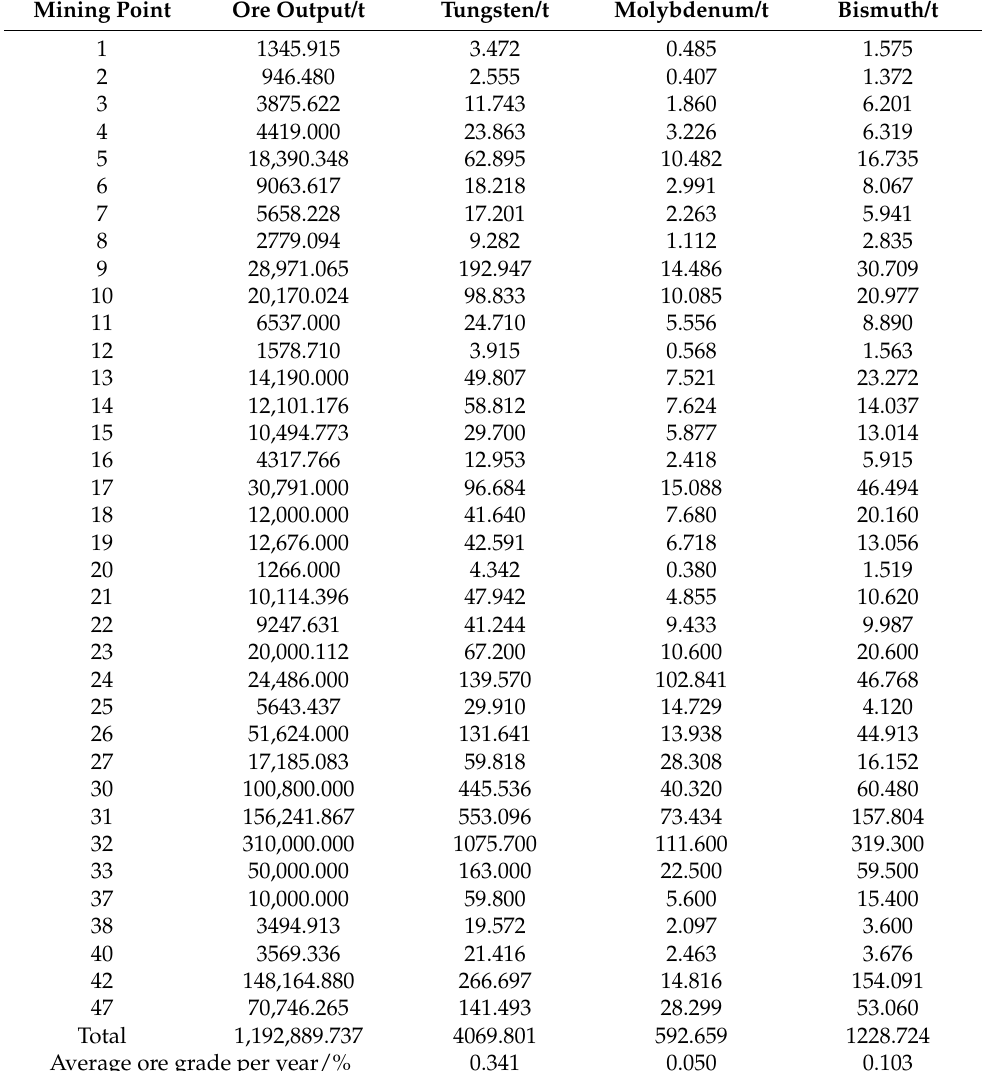
Table 6. The optimization results of the Shizhuyuan beneficiation